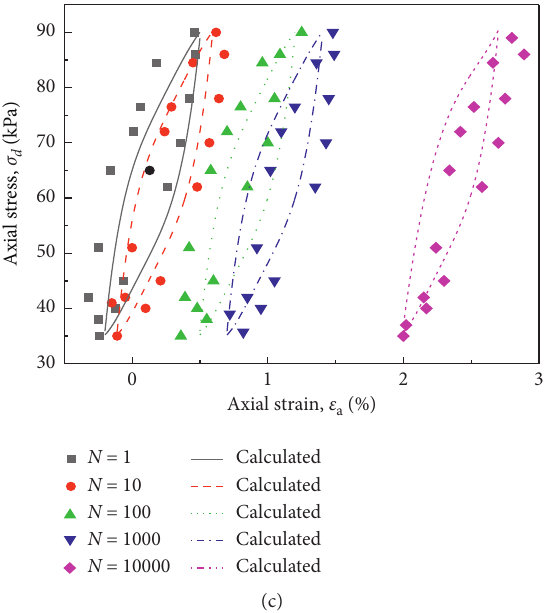
Figure 18: Application of accumulative plastic strain model on different soil samples: (a) A105, (b) A202, and (c)